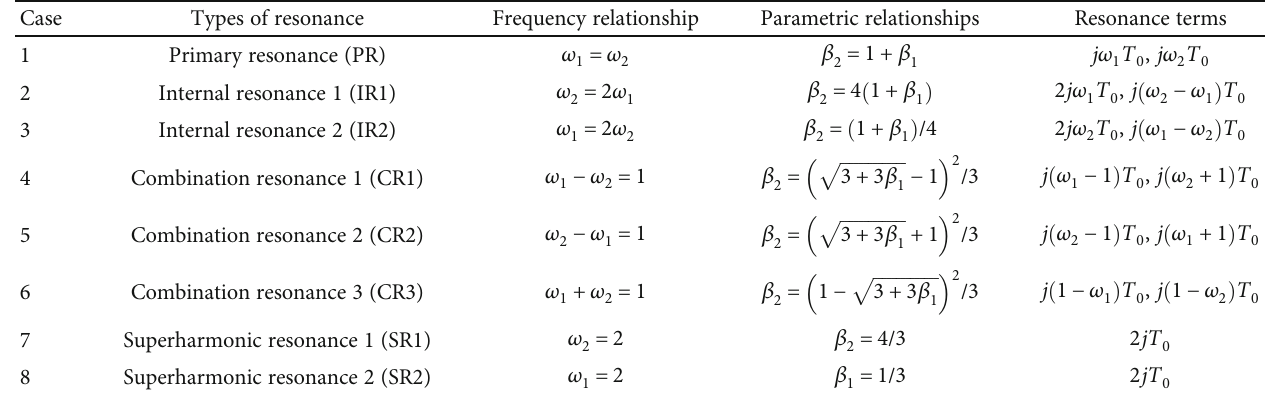
Table 1: Resonance types and their parametric